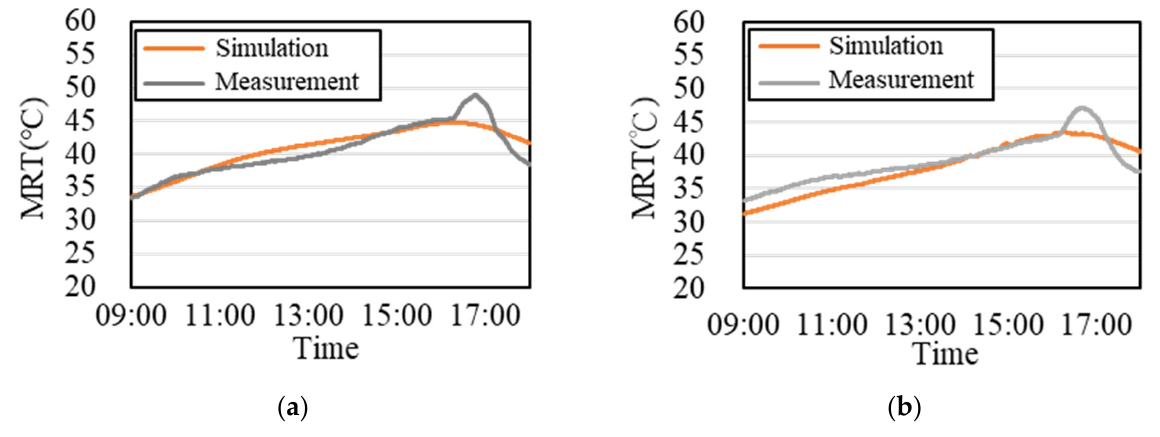
Figure 10. Air temperature comparison of simulation and measurement. ( a ) Without Expanded Metal Mesh; ( b ) With Expanded Metal Mesh.